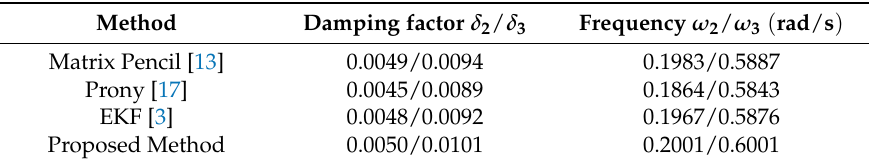
Table 2. Identified results of different